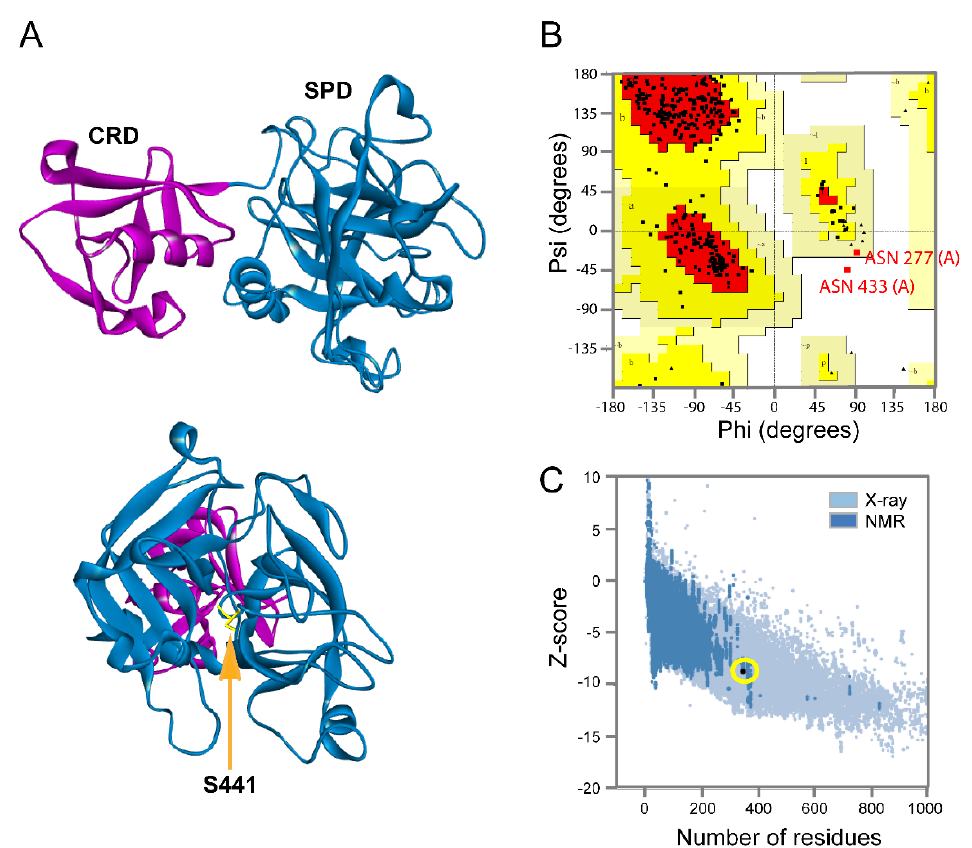
Figure 3. The homology model of human host transmembrane type 2 protease (Tmprss2). ( A ) The structural representation of the homology model obtained for human host protease Tmprss2 using the coordinates of hepsin protease (PDB ID: 5CE1) as a template. The protein has two main domains: the cysteine-rich domain (CRD), containing the residues 148–242, shown in magenta and the serine protease catalytic domain (SPD), containing the residues 255–489, shown in blue (upper panel). The front view of the catalytic domain. The key catalytic residue Ser441 is highlighted in yellow and indicated with an arrow. ( B , C ) The overall quality assessment of the Tmprss2 homology model using the Ramachandran and ProSA programs. Table 4. Binding free energies calculated for famotidine and other protease inhibitors upon docking to human host protease Tmprss2.